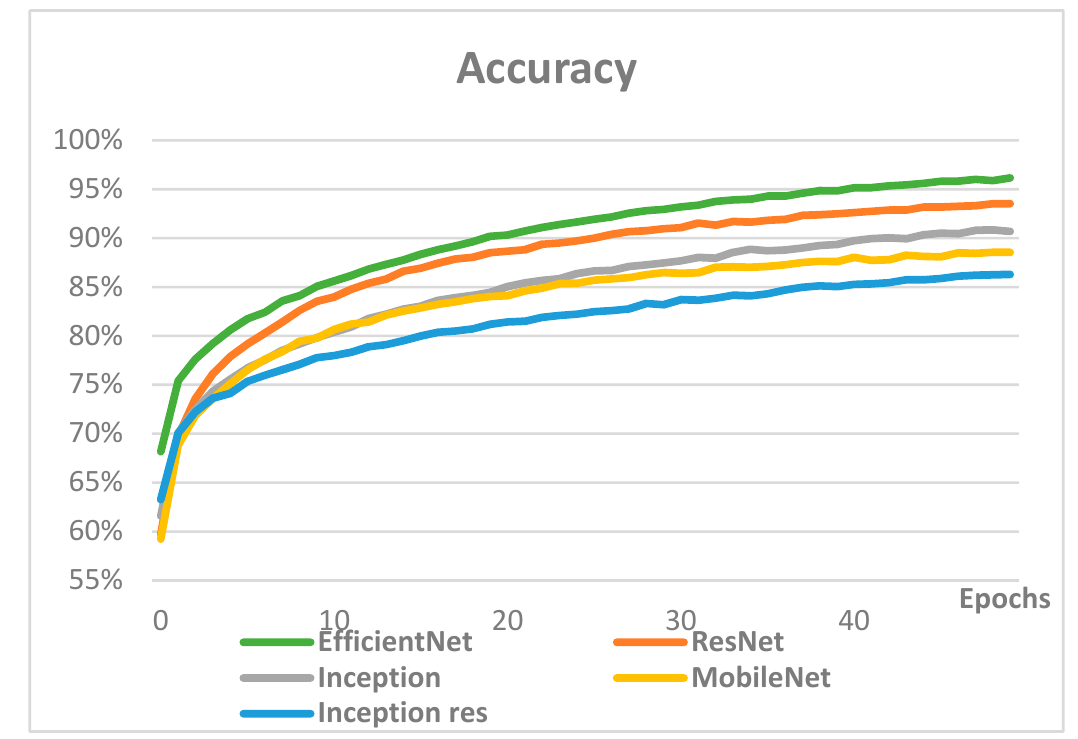
Figure 7. Accuracy comparison of the CNN-based models.